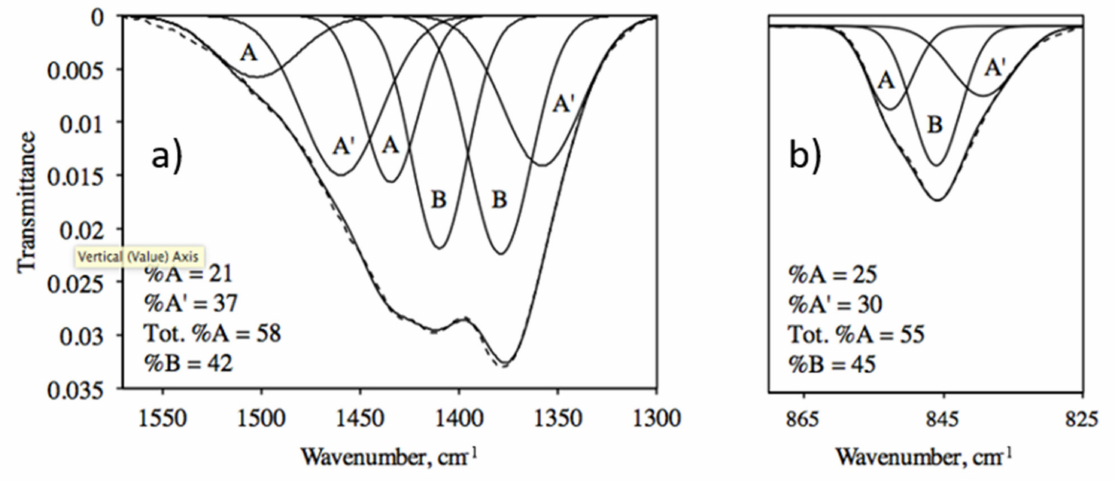
Figure 5. The carbonate ν 3 ( a ) and ν 2 ( b ) regions of the IR spectrum of